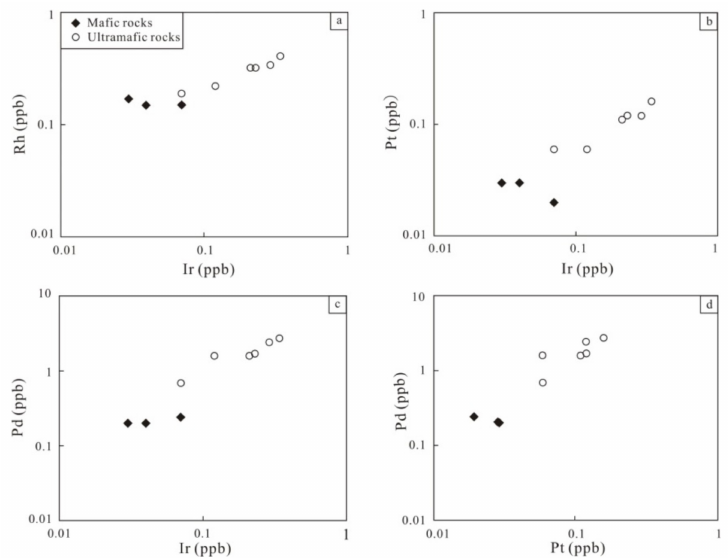
Figure 11. ( a ) Rh-Ir diagram; ( b ) Pt-Ir diagram; ( c ) Pd-Ir diagram; ( d ) Pd-Pt diagram for rocks from the Baixintan